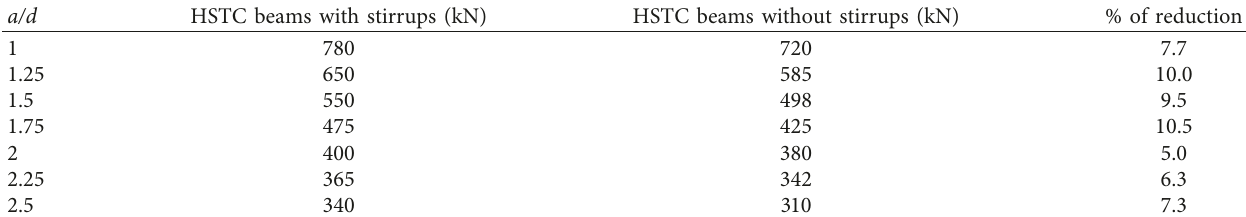
Figure 13: Modes of failure of RC beams using steel truss with a/d ratios between 1 and 2.5. (a) a/d � 1. (b) a/d � 1.5. (c) a/d � 2. (d) a/d � 2.5. Table 3: Comparison of ultimate loads carrying capacity of HSTC beams with and without shear reinforcement.